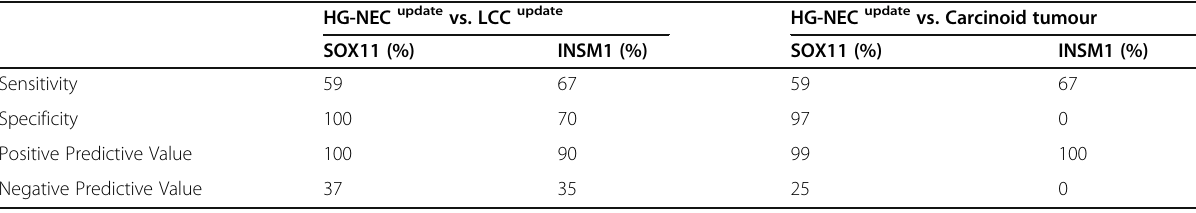
Table 2 Sensitivity and Specificity of SOX11 and INSM1 HG-NEC update vs. LCC